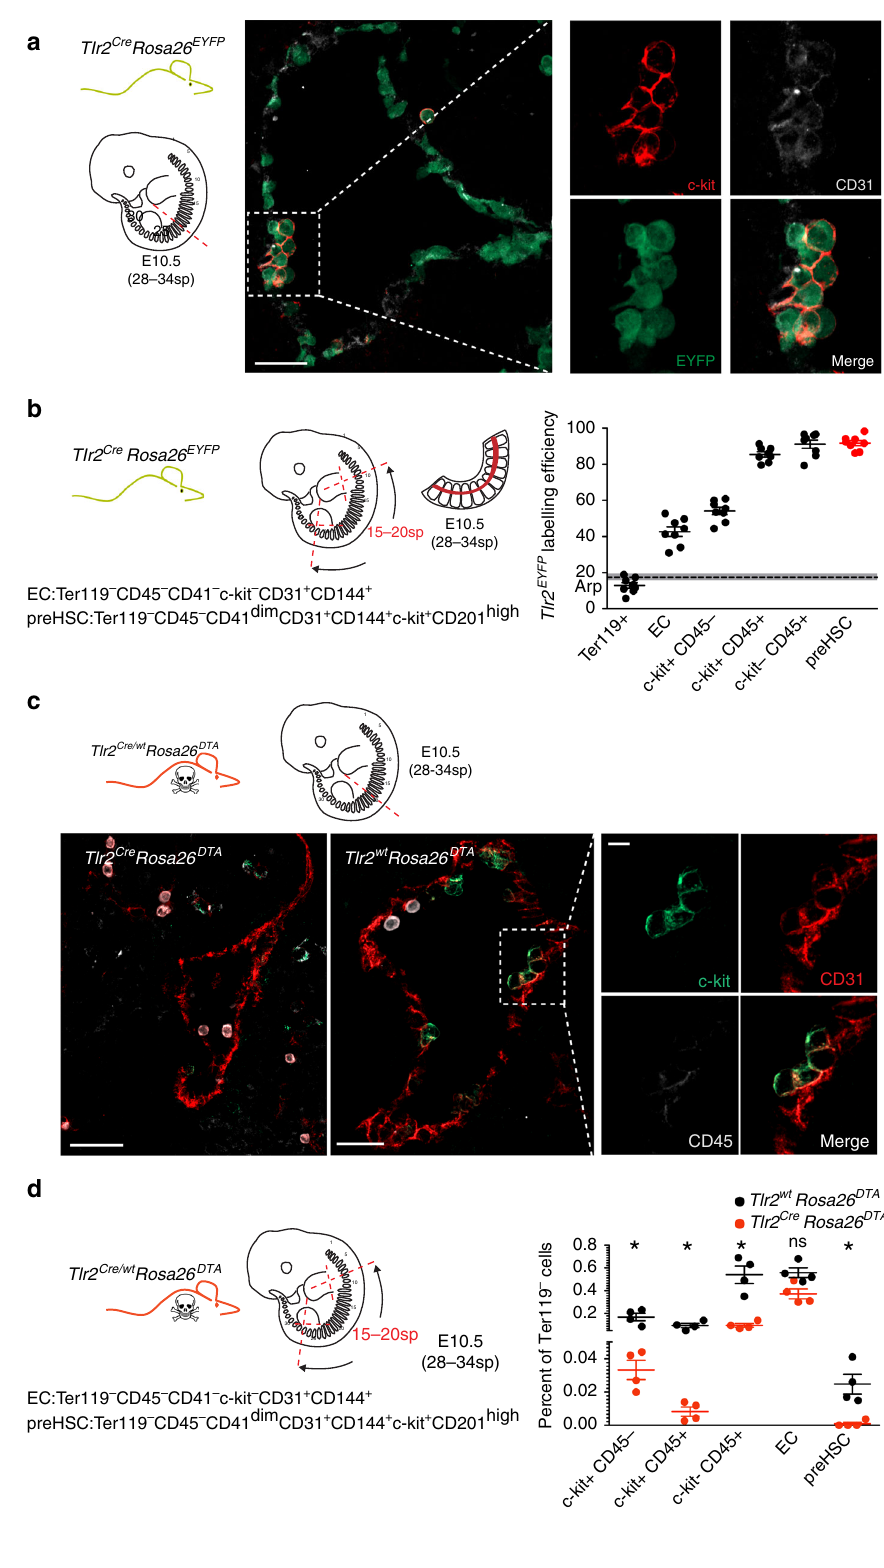
intra-aortic hematopoietic clusters (IAHCs) emerged from the CD31 + endothelium 10,37 . In addition to endothelial cells at the lining of the aorta, IAHCs were also labeled (Fig. 6a).